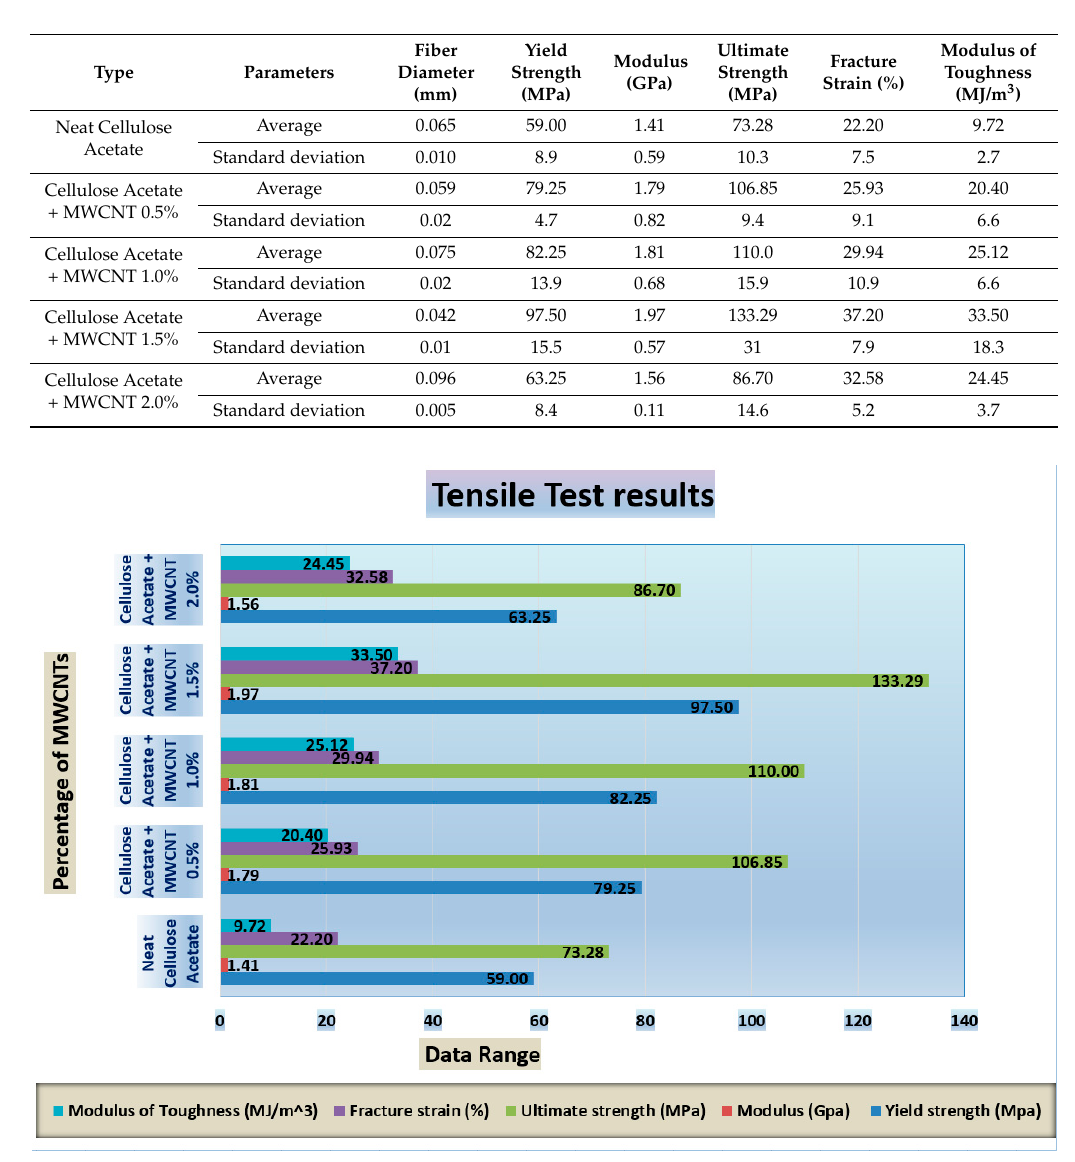
Figure 3. Representative tensile test results bar chart of ( a ) neat cellulose acetate (CA) ( b ) 0.5% cellulose acetate-multi-walled carbon nanotube (CA-MWCNT) ( c ) 1.0% CA-MWCNT ( d ) 1.5% CA-MWCNT ( e ) 2.0% CA-MWCNT.